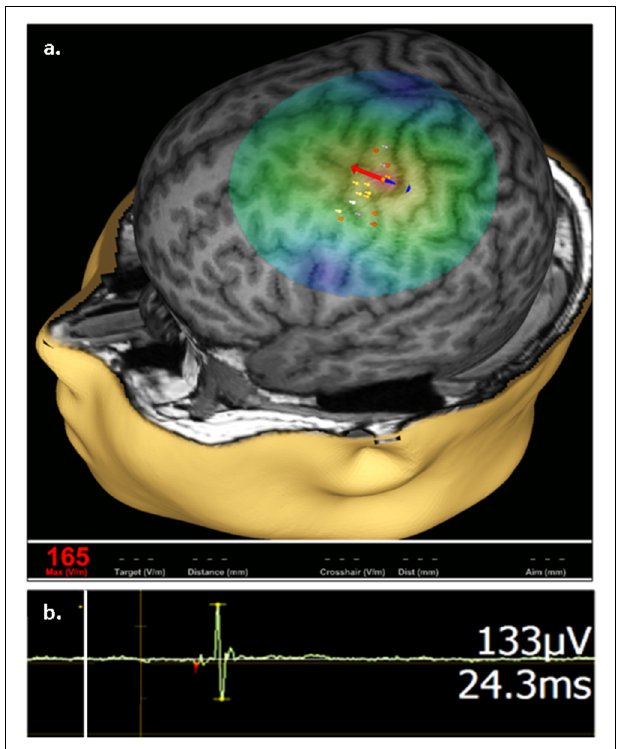
FIGURE 1 | Representative transcranial magnetic stimulation (TMS) motor cortex activation. (A) An approximation of stimulating electric field (e-field) induced by a single TMS pulse is displayed on a 3D reconstruction of an individual’s anatomic magnetic resonance imaging (MRI), where field center is indicated by the junction between the red and blue arrows, indicating the direction of induced current, with corresponding e-field strength at the stimulation site (V/m) shown in red in the bottom left. The composite map of left hemispheric stimulation sites evoking motor evoked potentials (MEPs) of the right abductor pollicis brevis (APB) muscle, where intensity of response is color coded (heat map) from lowest (gray) to highest (white), are displayed on the cortical surface rendering. (B) Representative right APB MEP sample (green deflection) showing right APB resultant from left hemisphere stimulation, where the vertical line (white) corresponds to stimulus time. MEP amplitude and latency are indicated on the